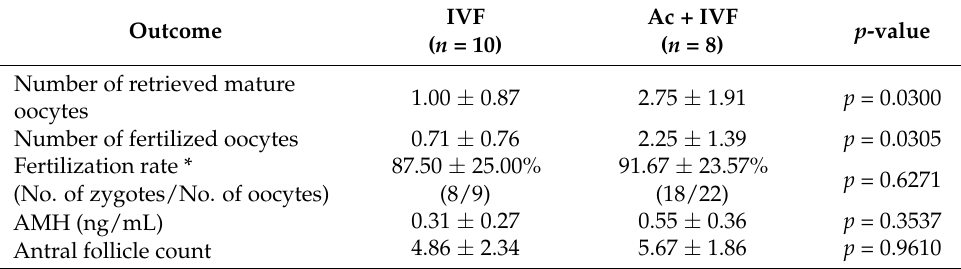
Table 8. Comparison of clinical outcomes of patients aged > 37 years in the two study groups.